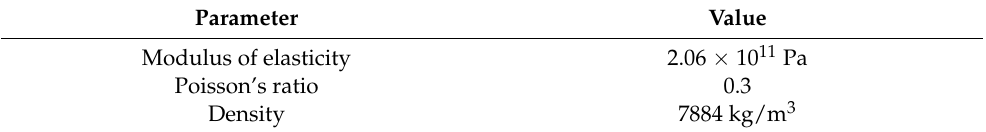
Table 2. Motor material parameters.